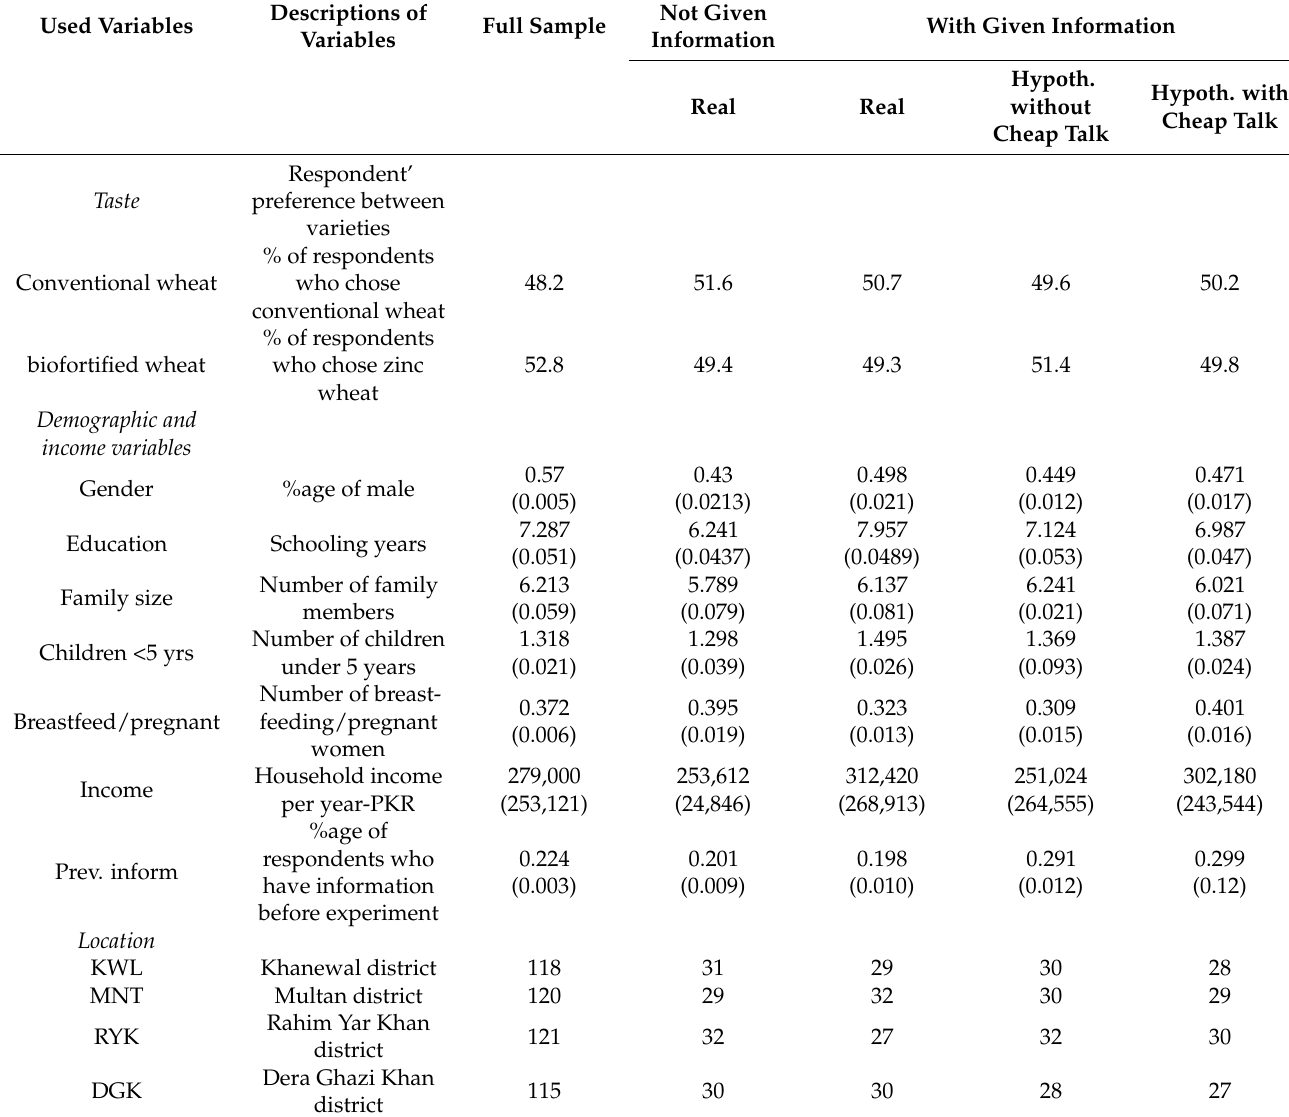
Table 3. Summary Statistics of socioeconomic variables under each